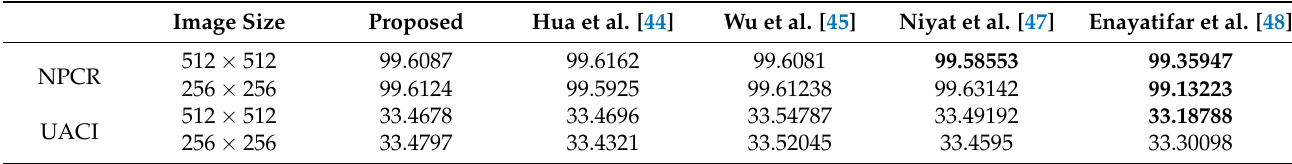
Table 7. Comparison of average values of NPCR and